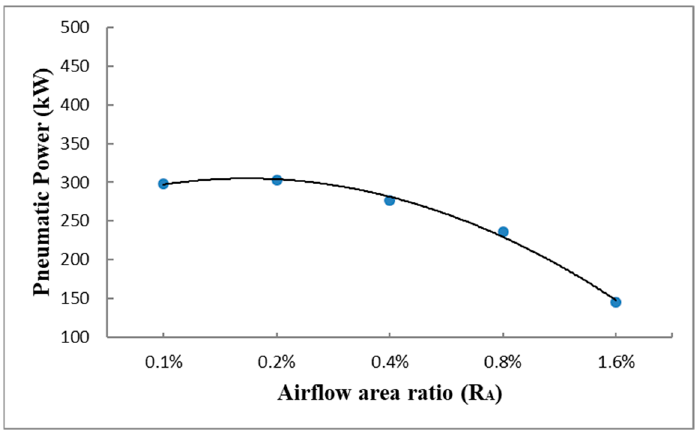
Figure 12. Pneumatic power corresponding to area ratio of orifice cross-section.